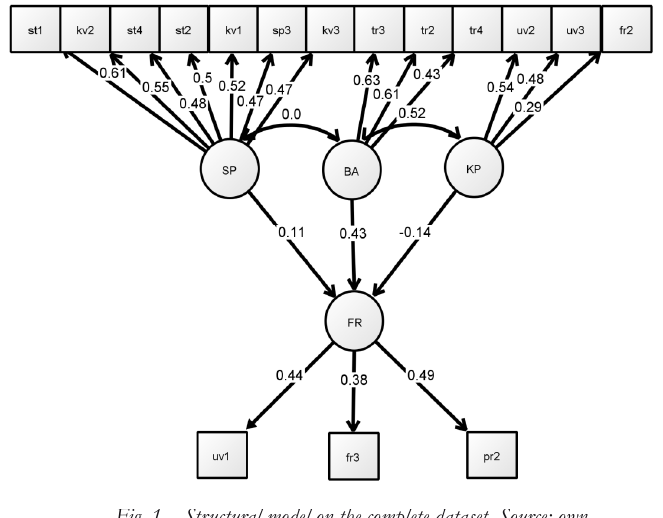
Fig. 1 – Structural model on the complete dataset. Source: